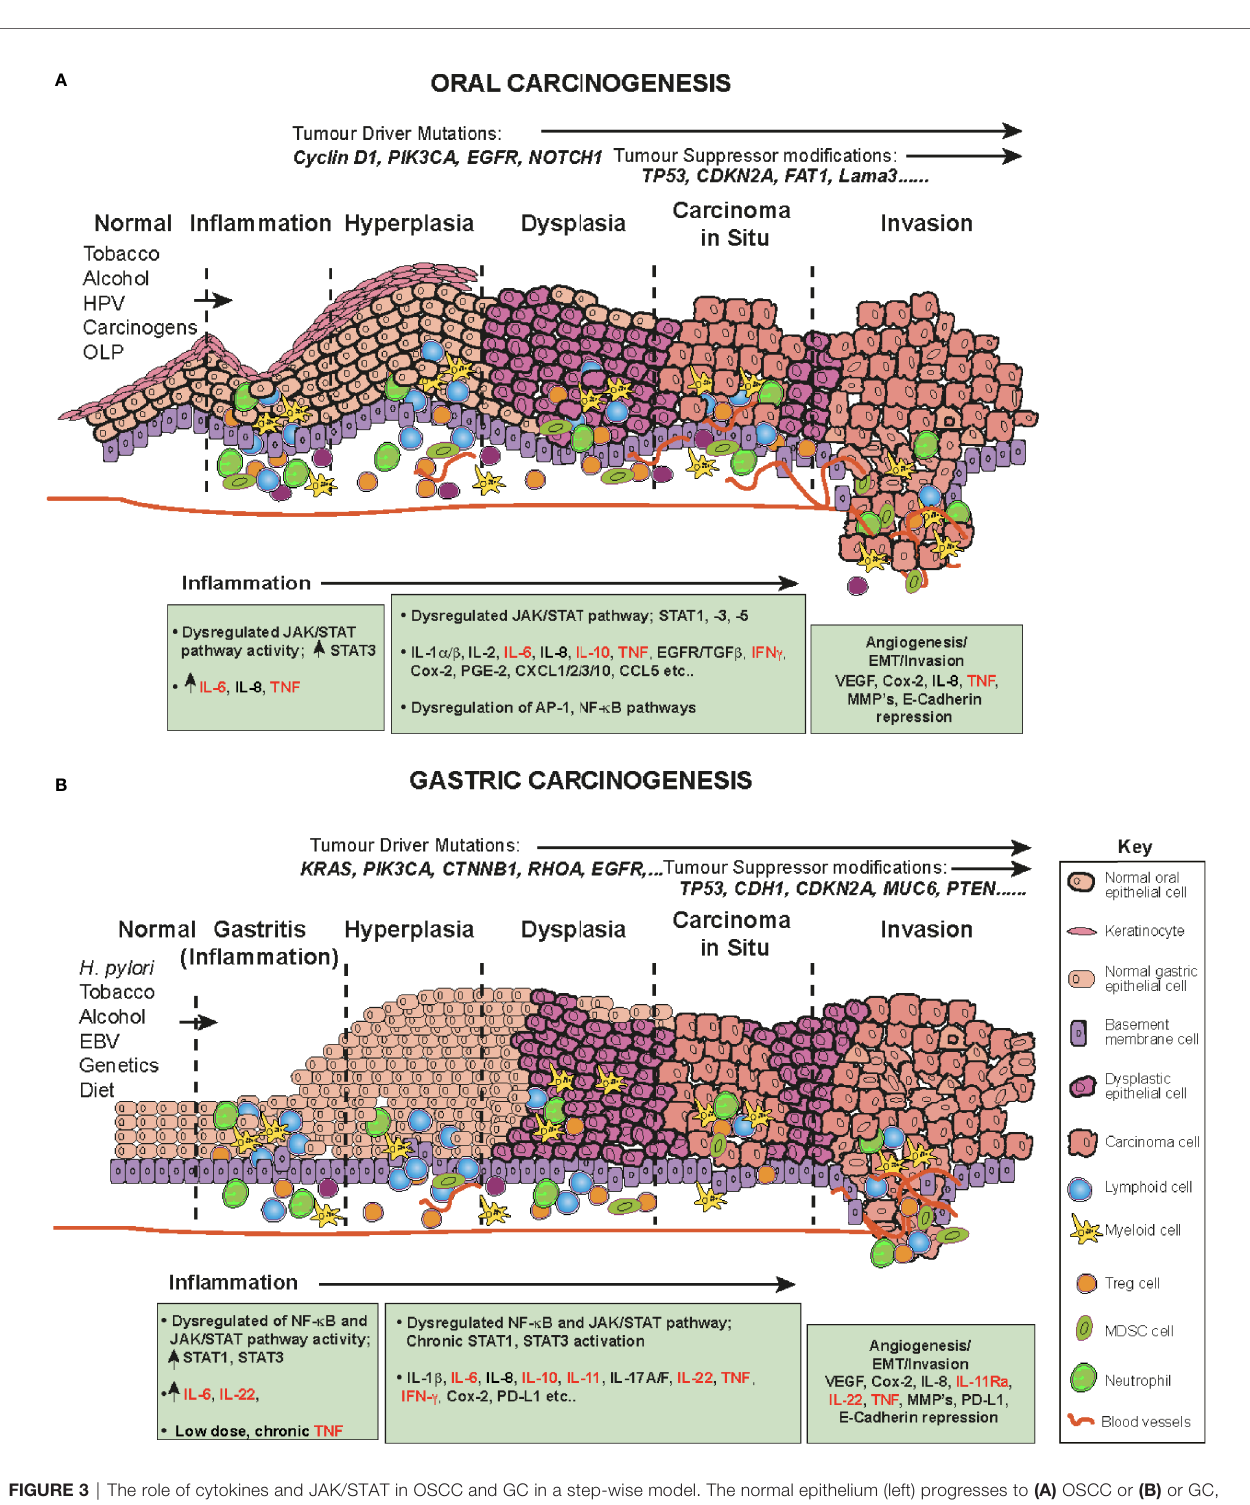
FIGURE 3 | The role of cytokines and JAK/STAT in OSCC and GC in a step-wise model. The normal epithelium (left) progresses to (A) OSCC or (B) or GC, through a series of histopathological precursors. During early disease stage the immune system is activated by in fl ammatory stimuli, resulting in both pro- tumor and anti-tumor effects mediated by in fl ammatory cells. The cytokine and JAK-STAT pathway are dysregulated within the cells of the in fl ammatory microenvironment and target genes serve as fuel to control both apoptosis and in fl ammation. Pro-in fl ammatory cytokine mediators promote neoplastic growth and development, proliferation, tissue remodeling (EMT), angiogenesis and metastases. During this progression, several alterations in key genes also accumulate (e.g. KRAS , TP53 ) to progress